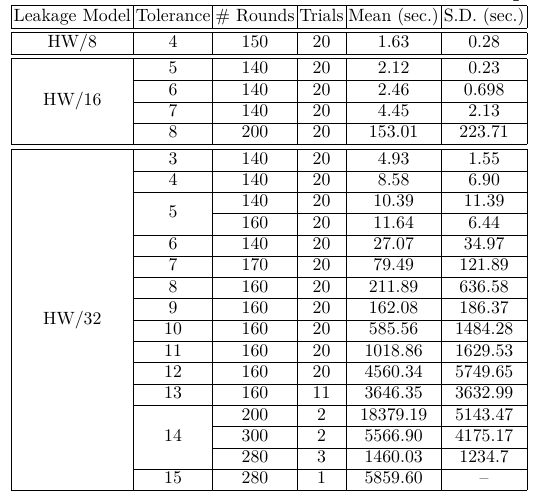
Table 6: Results on TRIVIUM in the initialisation